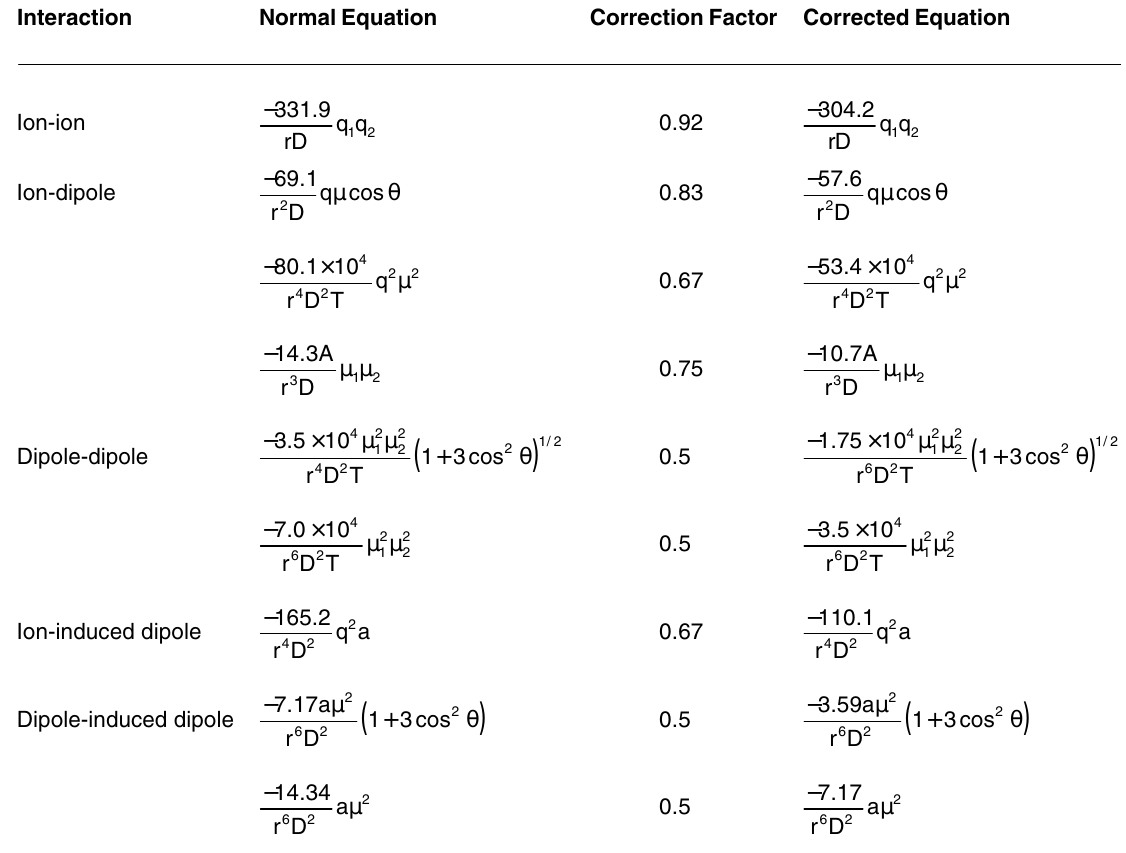
Expressions for Intermolecular Interactions Corrected for Short-Range